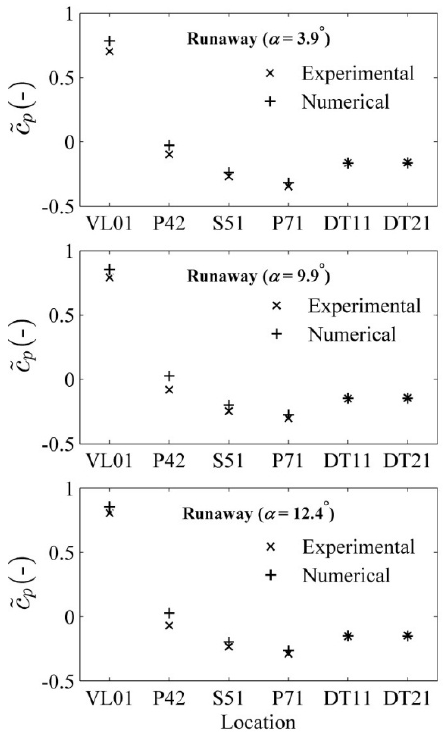
Figure 5. Comparison between the experimental and numerical values of pressure coefficient at different locations in the turbine, showing the runaway conditions at three angular positions of the guide vanes: 3.9, 9.9 and 12.4°.